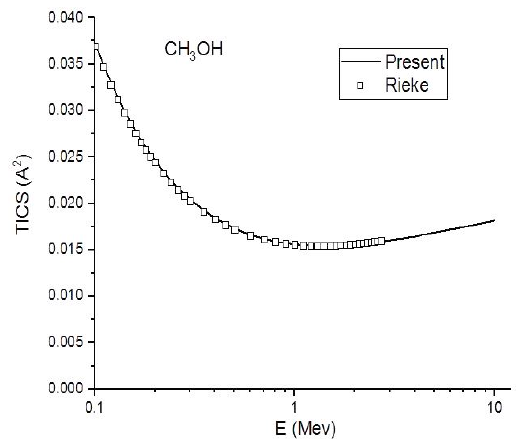
Figure 4. In this figure, we compare the present (Ave.) ( - ) total ionization cross section in A 2 to the experimental ( ) results of Rieke and Prepejchal [15] for CH 3 OH at a high energy range.